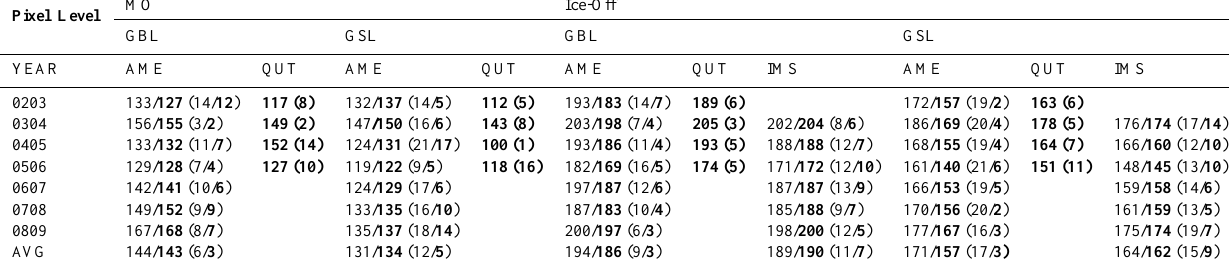
Table 7. Comparison of ice phenology variables for break-up period (MO and Ice-Off) daily-derived from AMSR-E (AME), QuikSCAT (QUT) and NOAA/IMS (IMS) products for GBL and GSL (2002–2009). Values within confidence regions in bold. Standard deviation in